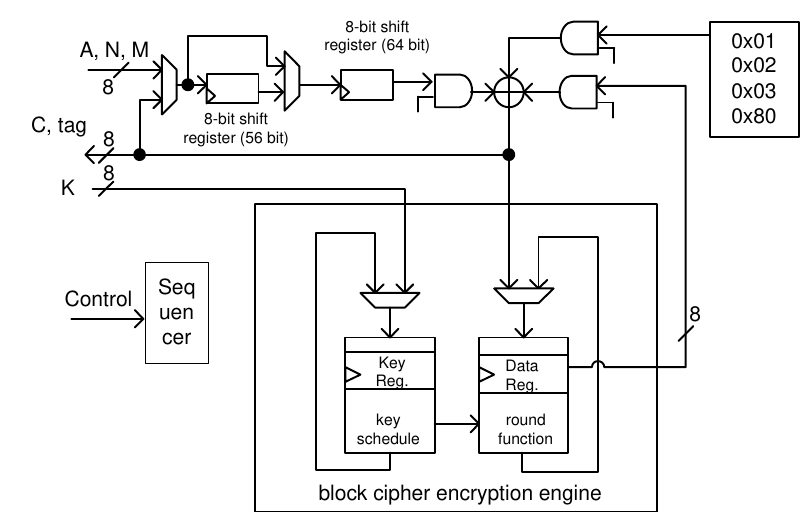
Figure 4: A lightweight hardware architecture for SAEB